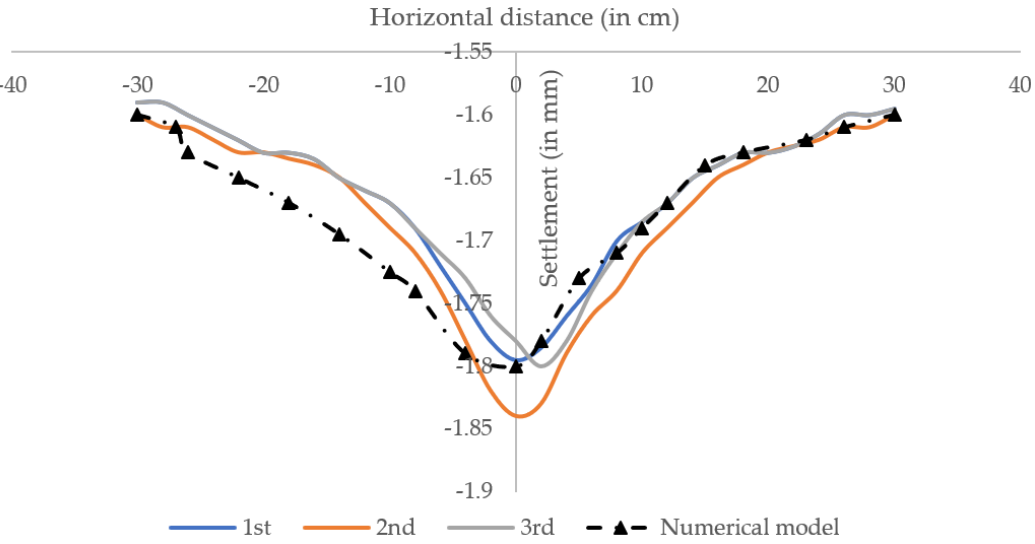
Figure 6. Settlement trough generated through lab experiment and numerical modelling on Optum G2.